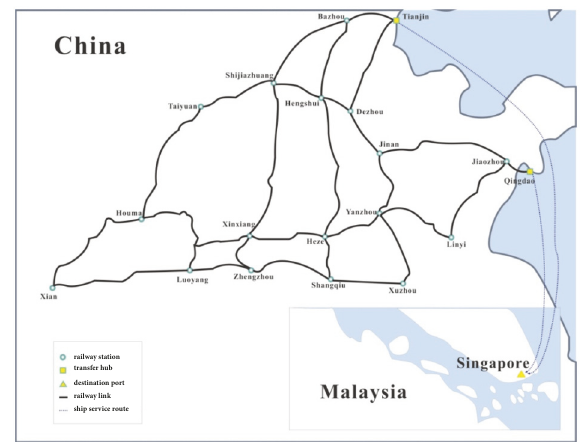
Figure 3: A realistic sea-rail intermodal network.